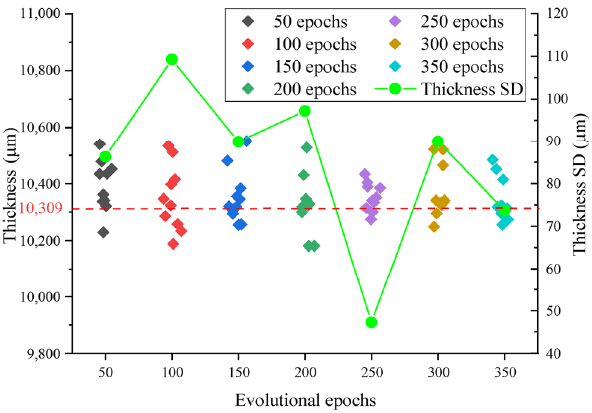
Fig. 15 Effect of different evolution epochs on thickness inversion results.